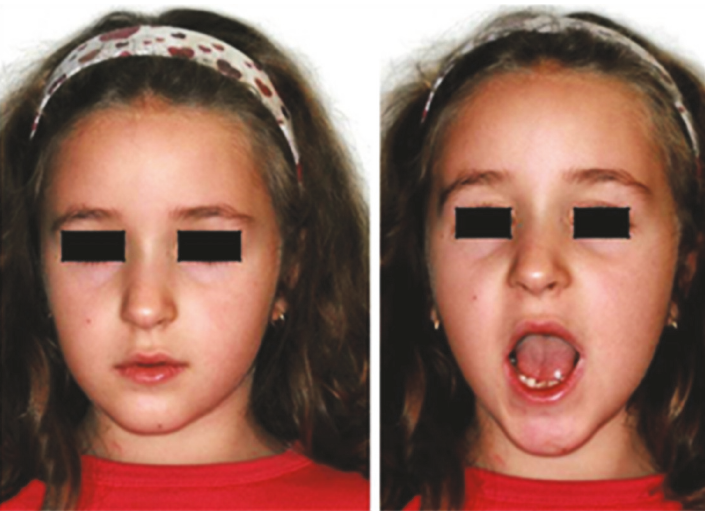
Figure 4: The good functional result of the therapy.